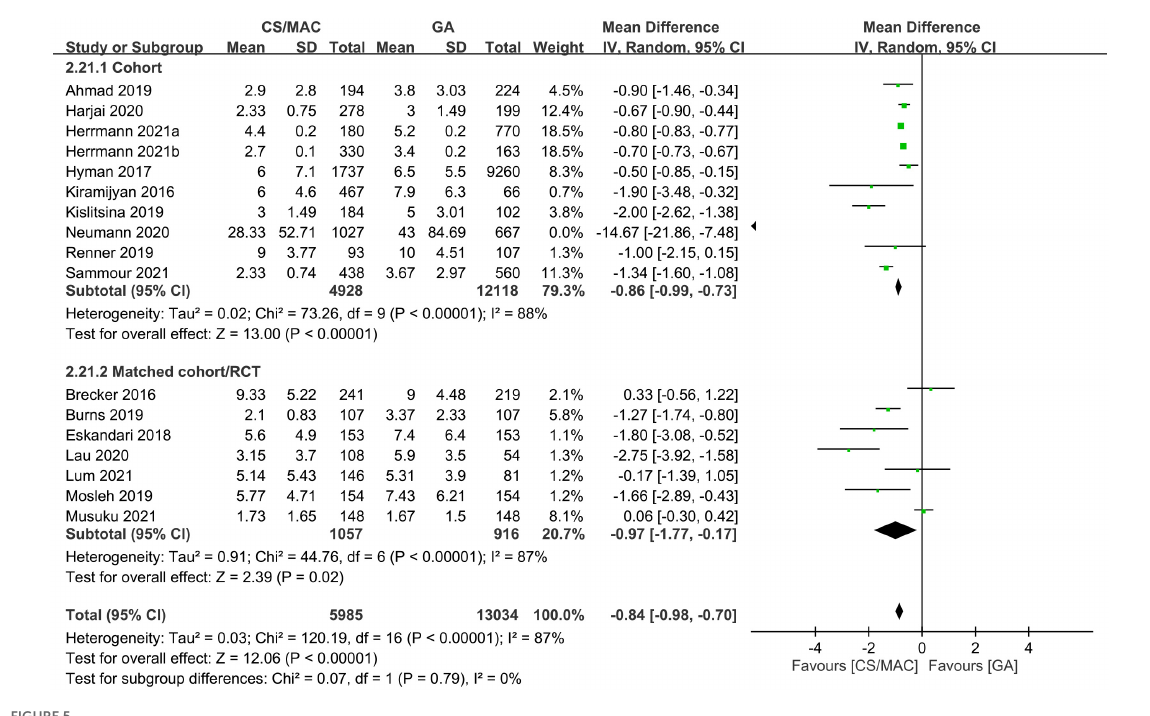
FIGURE5 Forest plot comparing the hospital length of stay between patients receiving conscious sedation/monitored anesthesia care (CS/MAC) and those subjected to general anesthesia (GA). CI, confidence interval; M-H,